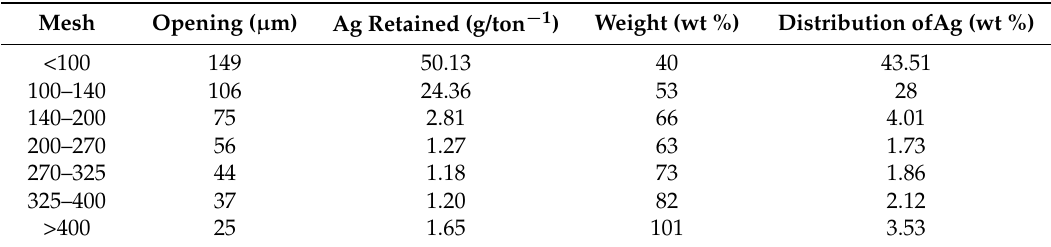
Table 2. Granulometric analysis of the Dos Carlos mine dumps